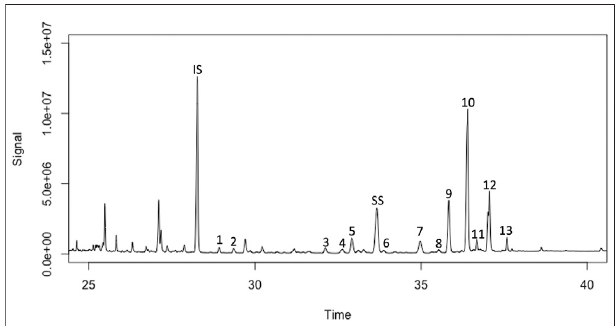
FIGURE 2 | Annotated gas chromatogram of sterols identi fi ed in Scenedesmus algal biomass; (1) MW 397, 28-carbon 4- desmethylsterols- similar to ergosterol; (2) MW 411, 29-carbon 4- desmethylsterols- triple unsaturated, (3) MW 401, 28-carbon 4- desmethylsterols- similar to campesterol or ergosta-7-en-3 β -ol; (4) MW 397, 28-carbon 4-desmethylsterols- similar to ergosterol; (5) MW 413, 29-carbon 4-desmethylsterols- similar to stigmasterol, fucosterol, or Δ 5- avenasterol; (6) MW 415, 29-carbon 4-desmethylsterols- similar to sitosterol or Δ 7-stigmastenol; (7) MW 397, 28-carbon 4- desmethylsterols- similar to ergosterol; (8) MW 415, 29-carbon 4- desmethylsterols- similar to sitosterol or Δ 7-stigmastenol; (9) MW 401, 28-carbon 4-desmethylsterols- similar to campesterol or ergosta-7-en- 3 β -ol; (10) MW 413, 29-carbon 4-desmethylsterols- similar to stigmasterol, fucosterol, or Δ 5-avenasterol; (11) MW 401, 3 β - (trimethylsiloxy)-5.Xi.-Egost-7-ene; (12) MW 415, 29-carbon 4- desmethylsterols- similar to sitosterol or Δ 7-stigmastenol; (13) MW 415, 3 β -(trimethylsiloxy)-5.Xi.-Stigmast-7-ene, IS (cid:1) internal standard, cholestanol was included as an internal, non-native, standard for recovery calculations, and SS (cid:1) surrogate standard,